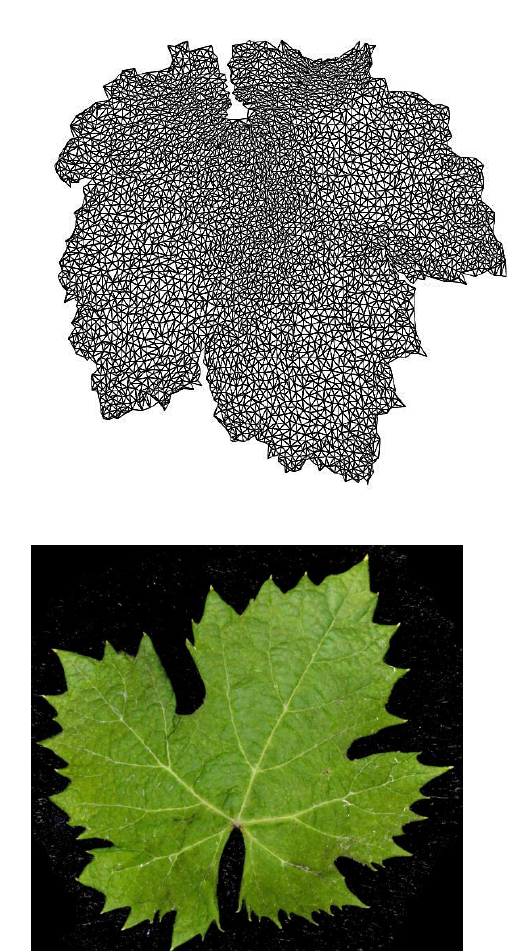
Figure 14. Vector mesh and orthophoto of the leaf of the Boscoreale vine and the precision along the z axis is: